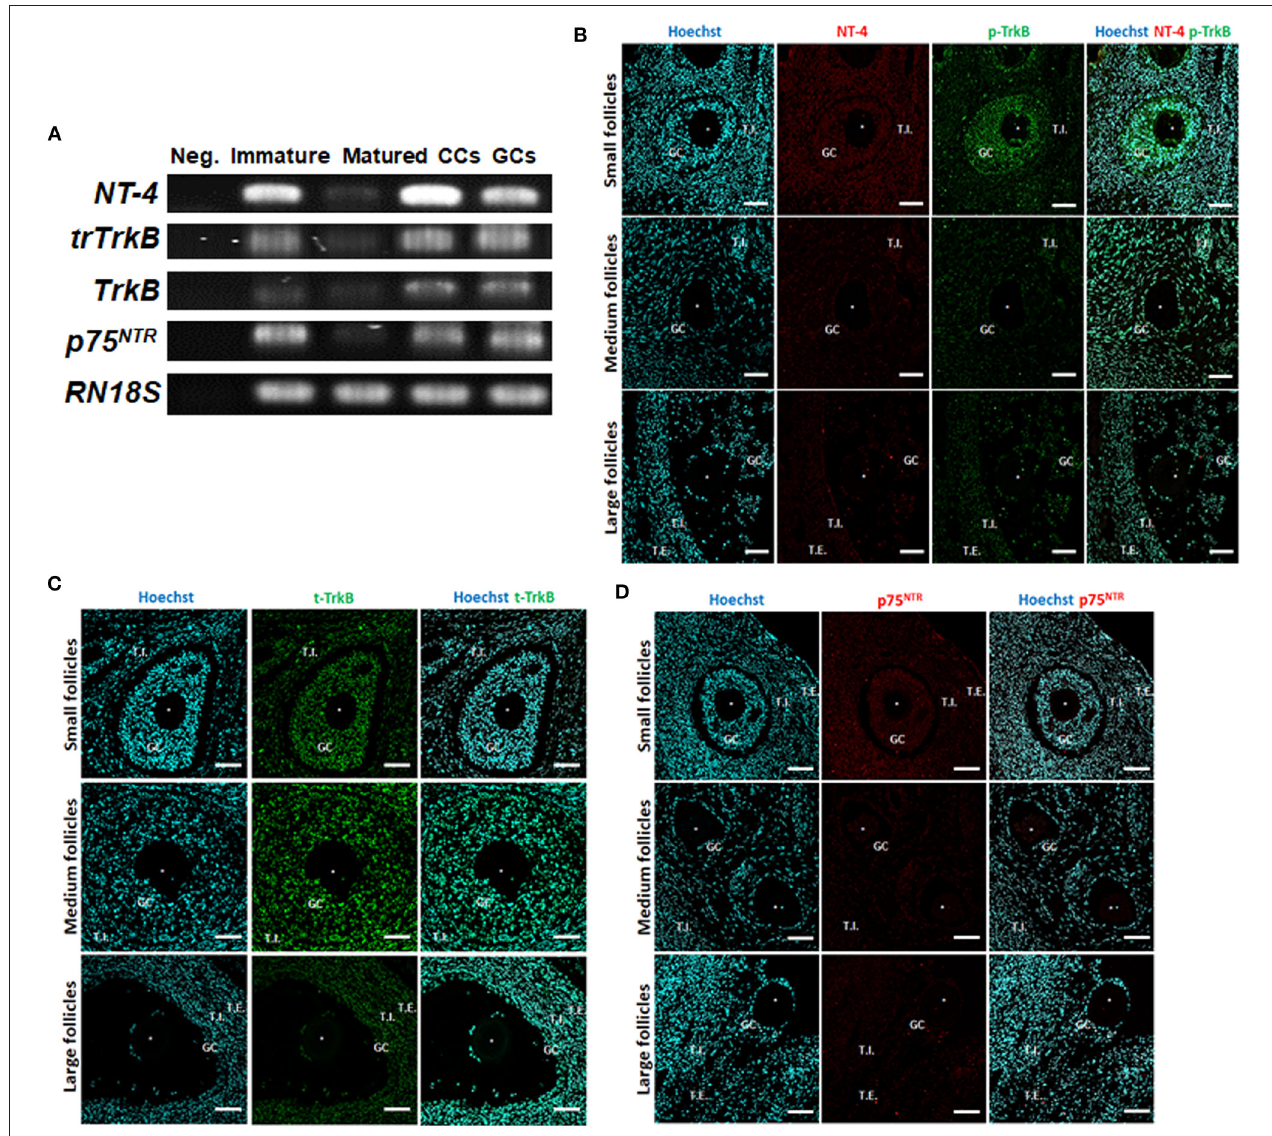
FIGURE 1 | Identification and localization of neurotrophin-4 (NT-4) and its receptors in porcine ovarian follicular cells by RT-PCR and fluorescent immunohistochemistry. (A) Expression of NT-4 , full-length tropomyosin receptor kinase B ( TrkB ), truncated TrkB ( trTrkB ), and pan-neurotrophin receptor ( p75 NTR ) mRNAs in porcine ovarian follicular cells, immature and matured oocytes was determined via RT-PCR. RN18S served as a ubiquitously expressed control. Distilled water was used as the negative control (Neg.). CCs, Cumulus cells; GCs, Granulosa cells. This experiment was replicated at least three times. (B–D) Identification and localization of NT-4 and its receptors in porcine ovaries via fluorescent immunohistochemistry. Pig ovarian tissues were divided into small (1–2mm), medium (3–6mm), and large (7–9mm) sections according to follicle size. (B) NT-4 and Phospho-TrkB (p-TrkB). (C) Total TrkB (t-TrkB). (D) p75 NTR . T.I., Theca interna cells; T.E., Theca externa cells. Asterisks represent